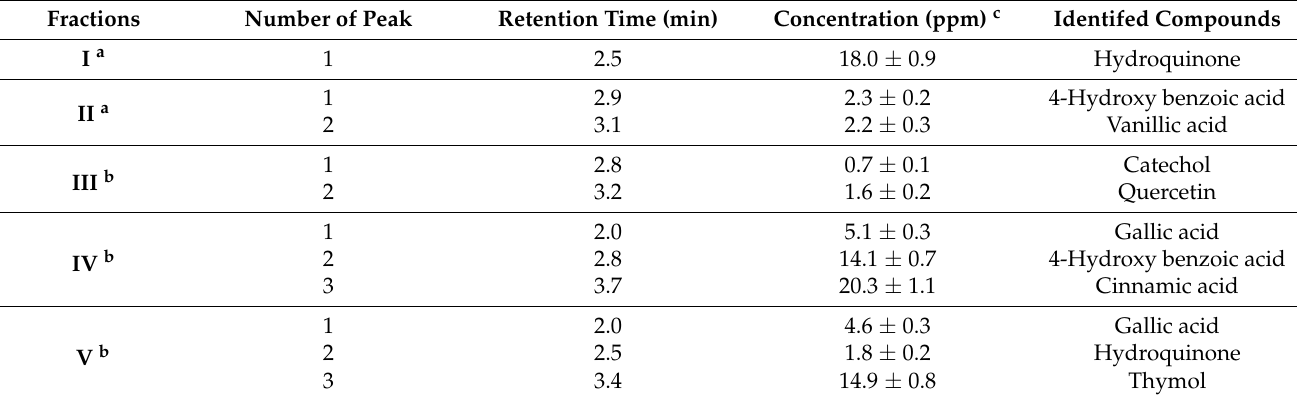
Table 1. Phenolic compounds in different fractions and their retention time. Fractions Number of Peak Retention Time (min) Concentration (ppm)